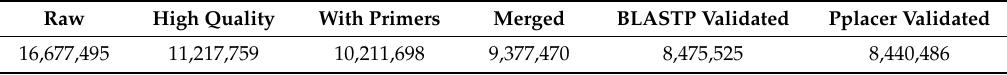
Table 1. Overview of number of analyzed sequences.